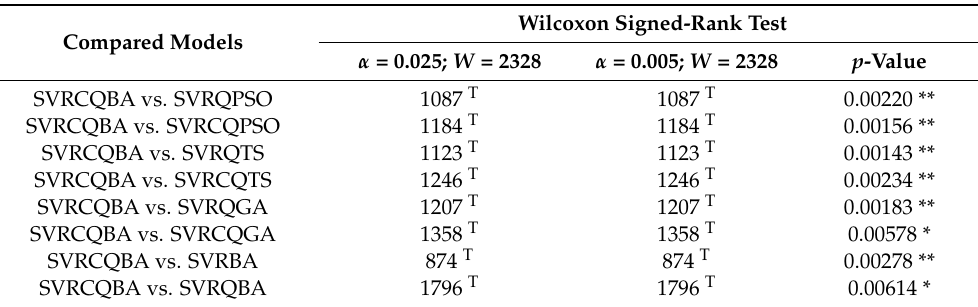
Table 3. Results of Wilcoxon signed-rank